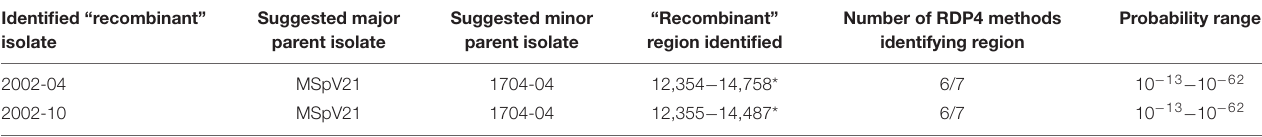
TABLE 2 | Potential reassortment regions identified among maize stripe virus isolates using recombination detection program v.4.101